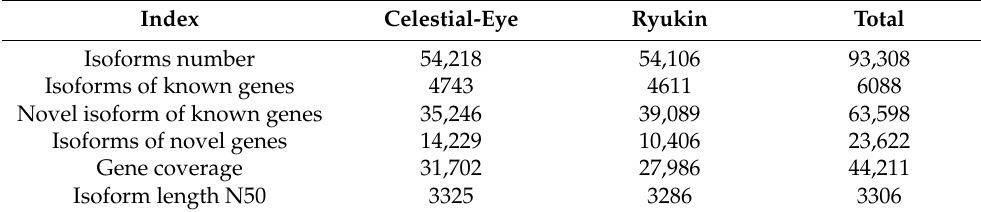
Table 2. Summary of identified transcript isoforms in goldfish embryos.